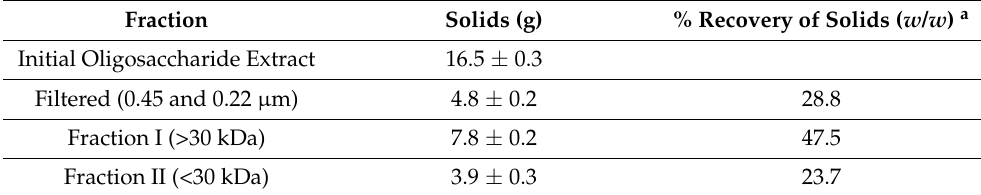
Table 3. Oligosaccharide extract fractionation by